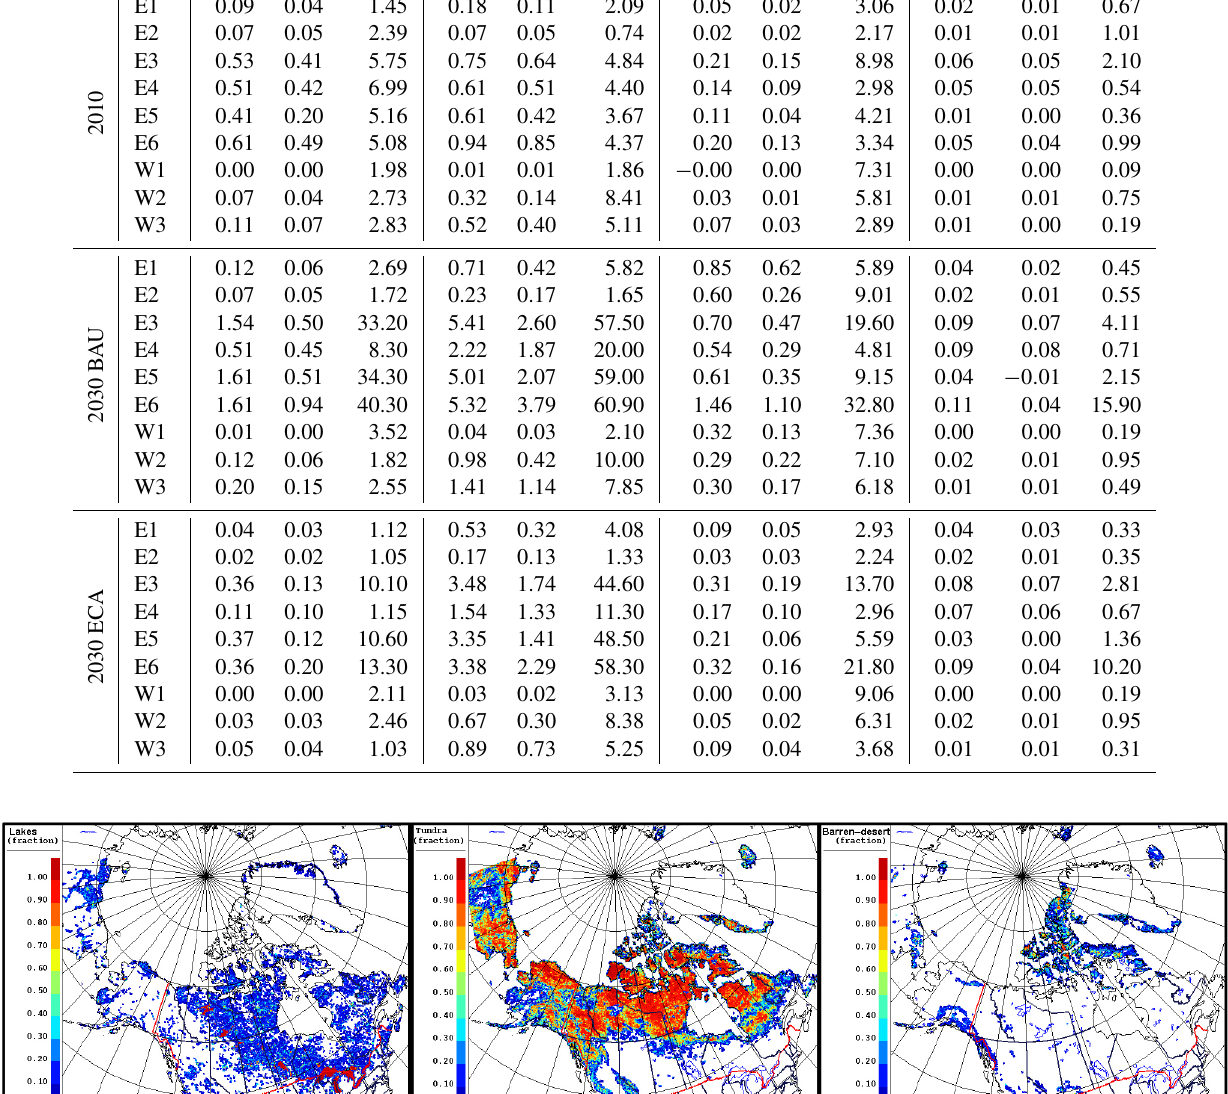
Figure 17. Gridded land-cover fractions for lakes, tundra, and barren–desert based on USGS v2.0 at 1km